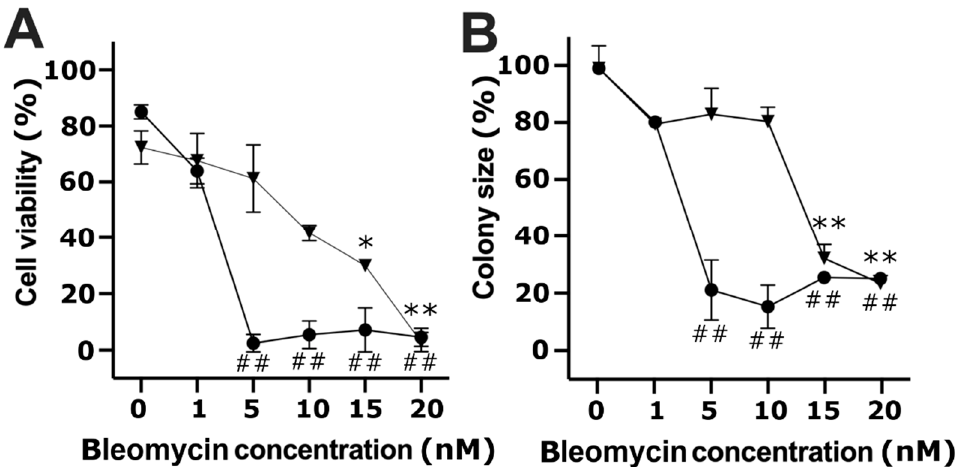
Figure 2. Cell viability ( A ) and cell colony size ( B ) changes after bleomycin electrotransfer (direct treatment) and after cell incubation in the medium taken from directly treated cells (indirect treatment) dependance on bleomycin concentration. For cell electroporation, a single 1400 V/cm strength and 100 µs duration electric pulse was used. The circles and triangles represent directly and indirectly treated cells, respectively. The * and ** or ## symbols represent statistical significance of p < 0.05 and p < 0.01, respectively, compared to the control.